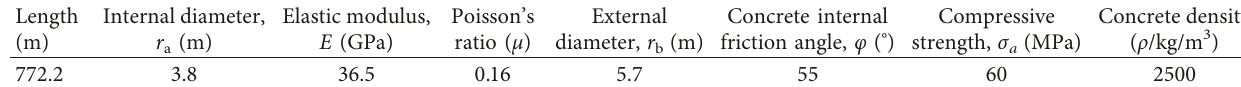
Table 2: Parameters of the shaft lining in Xieqiao coal